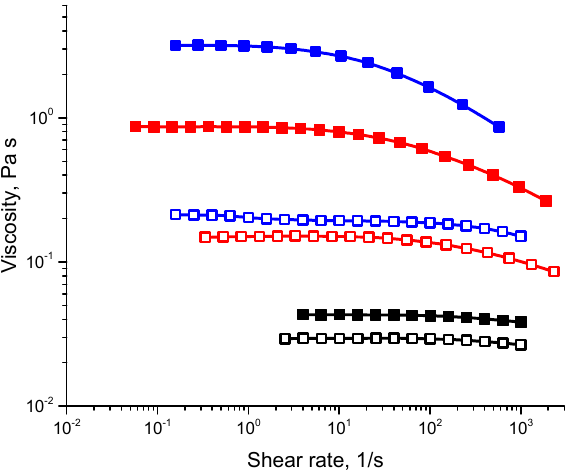
Figure 3. Flow curves of PAA, PAH and PECs in water or water / ethanol co-solvent; black—PAH; blue—PAA; red—PEC; Open squares—dissolved in water; full squares—dissolved in water / ethanol.